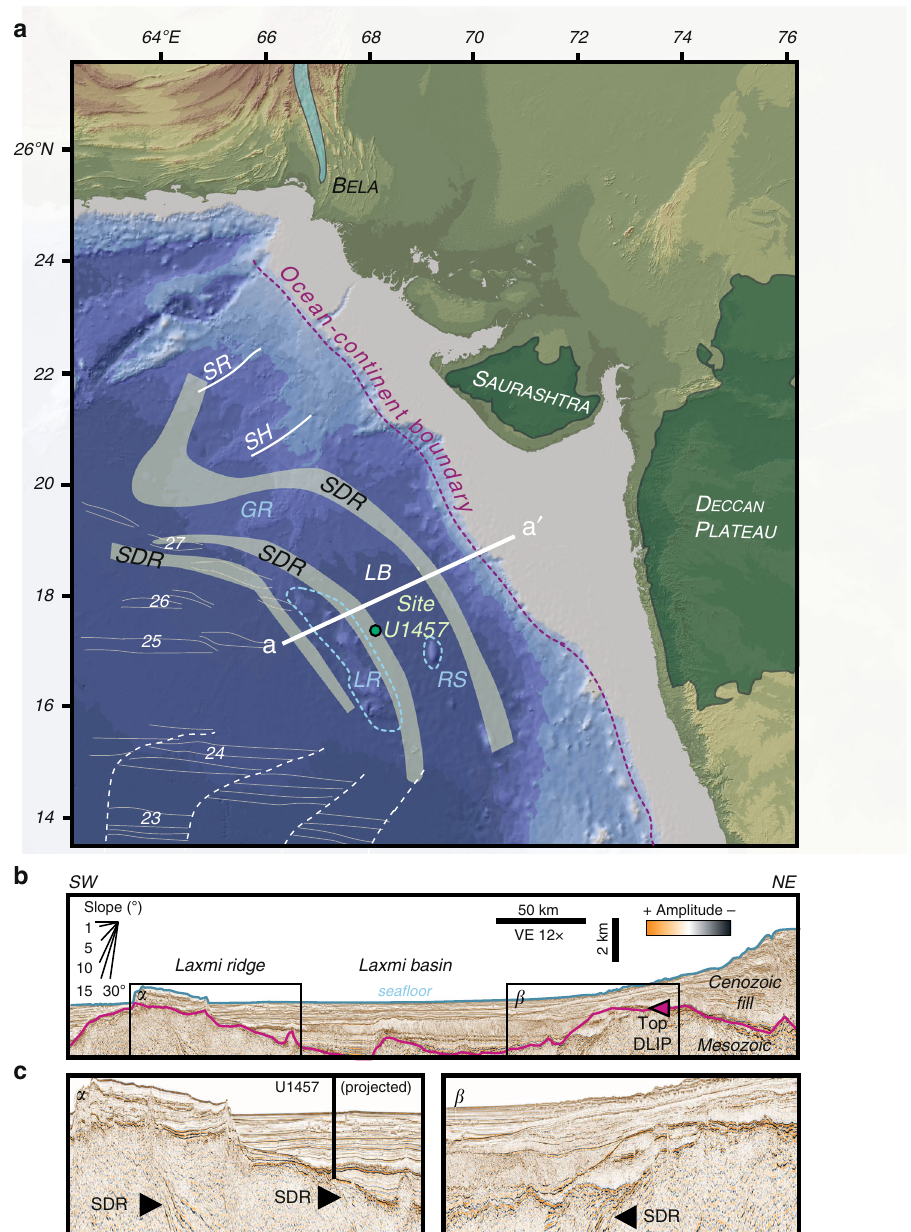
Fig. 1 Location and Geophysical Images. a Shaded bathymetric map of the Arabian Sea and surrounding regions, showing the location of IODP Site U1457, proposed continent-ocean boundaries (yellow dashed lines), the extent of known seaward dipping re fl ectors from Calvès et al 4 . Magnetic anomalies (thin grey numbered lines) and transform fault (dashed white lines). SDR seaward-dipping re fl ector, SR Somnath Ridge, SH Saurashtra High, GR Gop Rift, LR Laxmi Ridge, LB Laxmi Basin, RS Raman Seamount. b Seismic re fl ection pro fi le across LR and LB showing presence of SDRs, position of ocean-continent boundary (OCB) and the Deccan Large Igneous Province (DLIP). c) Close-up of LR showing east-dipping SDRs in α and β